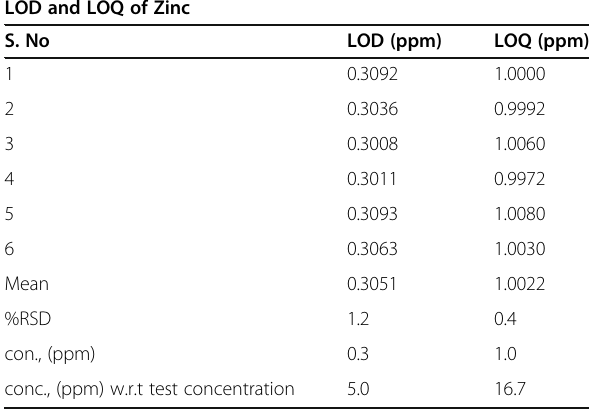
Table 5 LOD and LOQ experiments of Zinc LOD and LOQ of Zinc